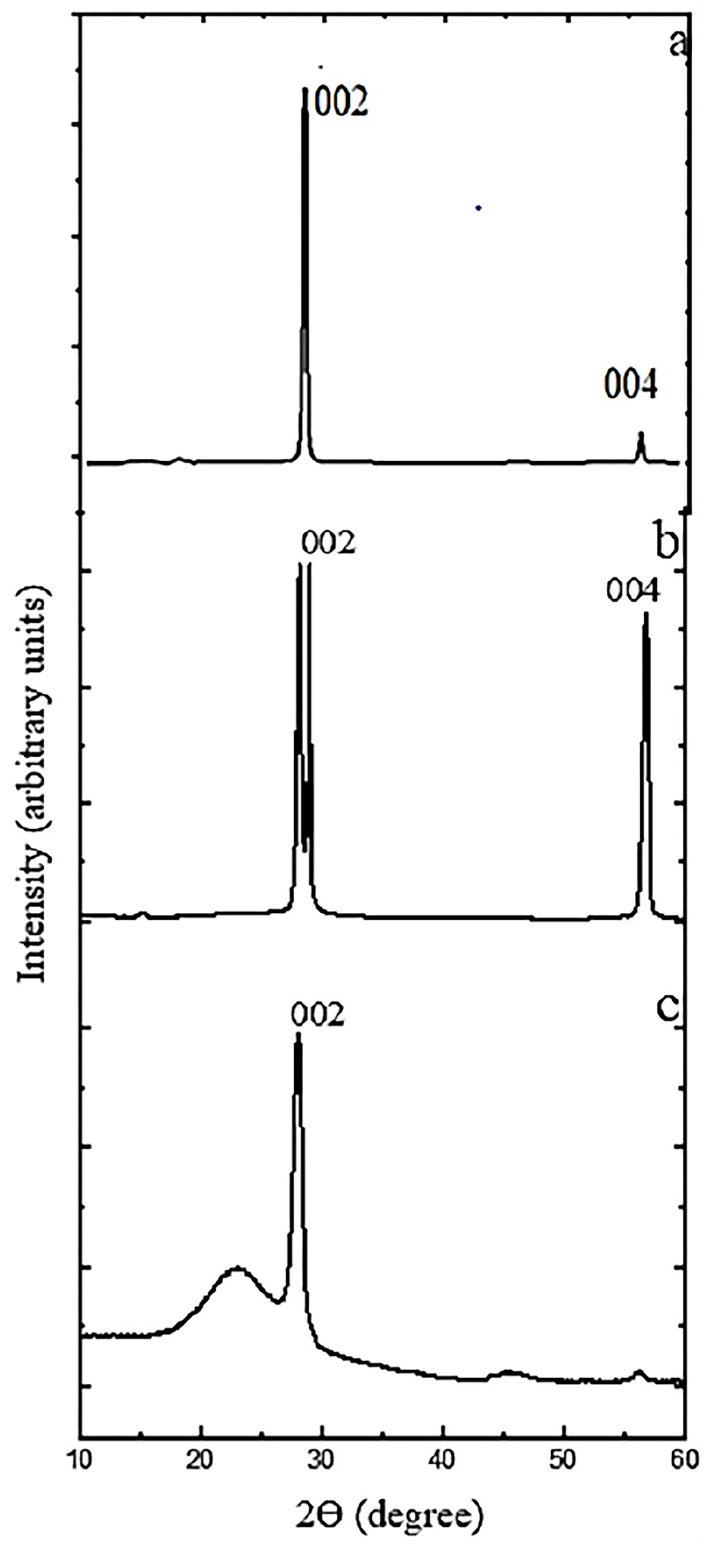
Figure 3. X-ray diffraction (XRD) patterns of AG ( a ), NG ( b ), EG ( c ).